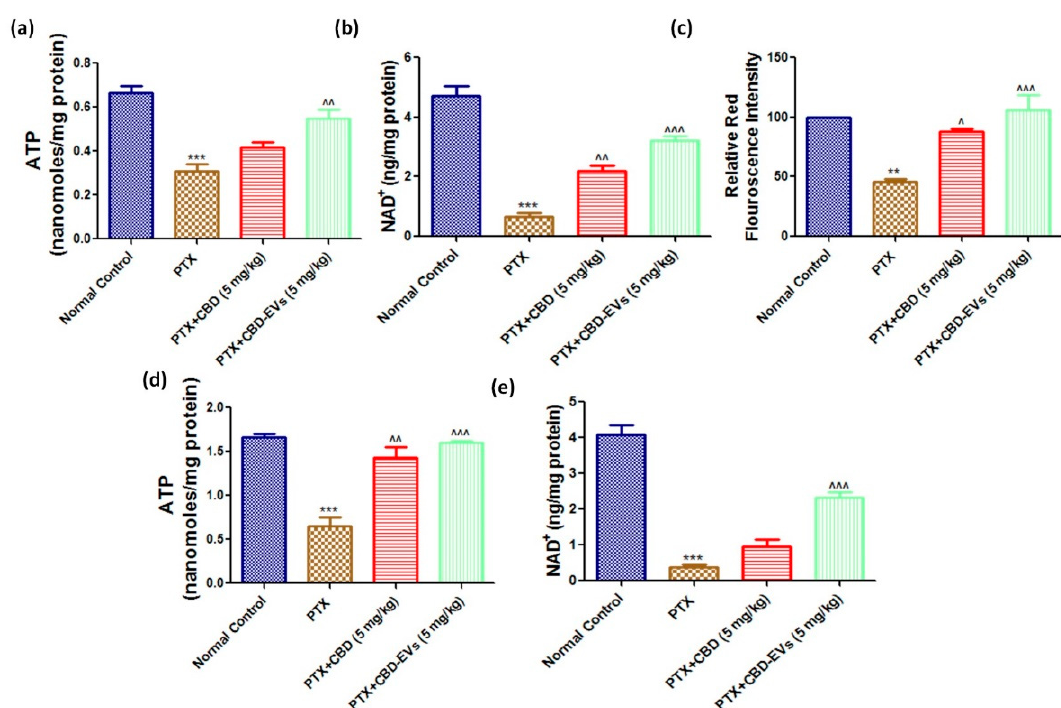
Figure 7. Effect of CBD and CBD-EVs on Mitochondrial Function and mitochondrial membrane potential ( ΔΨ m). ( a ) Representative bar graphs showing the ATP levels in Fresh DRG homogenates and ( d ) spinal homogenates of PTX-treated mice, ( b ) bar graph showing NAD + levels in DRG homogenates and ( e ) in spinal homogenates of PTX-treated mice, ( c ) Bar graph represents the JC1 trimer aggregates relative red fluorescence intensity. Values are expressed as mean ± SEM (n = 3). ** p < 0.01 and *** p < 0.001 vs. Normal control, ˆ p < 0.05, ˆˆ p < 0.01 and ˆˆˆ p < 0.001 vs. PTX (8 mg/kg). NC: untreated age-matched mice, PTX: mice received (8 mg/kg/day) on alternate days for four injections cumulatively, PTX + CBD (5 mg/kg): 5 mg/kg CBD (i.p.) injected twice a week for six weeks after the last PTX injection, PTX + CBD-EVs: 5 mg/kg of CBD loaded in hUCMSCs-derived EVs (i.p.) injected twice a week for six weeks after the last dose of PTX